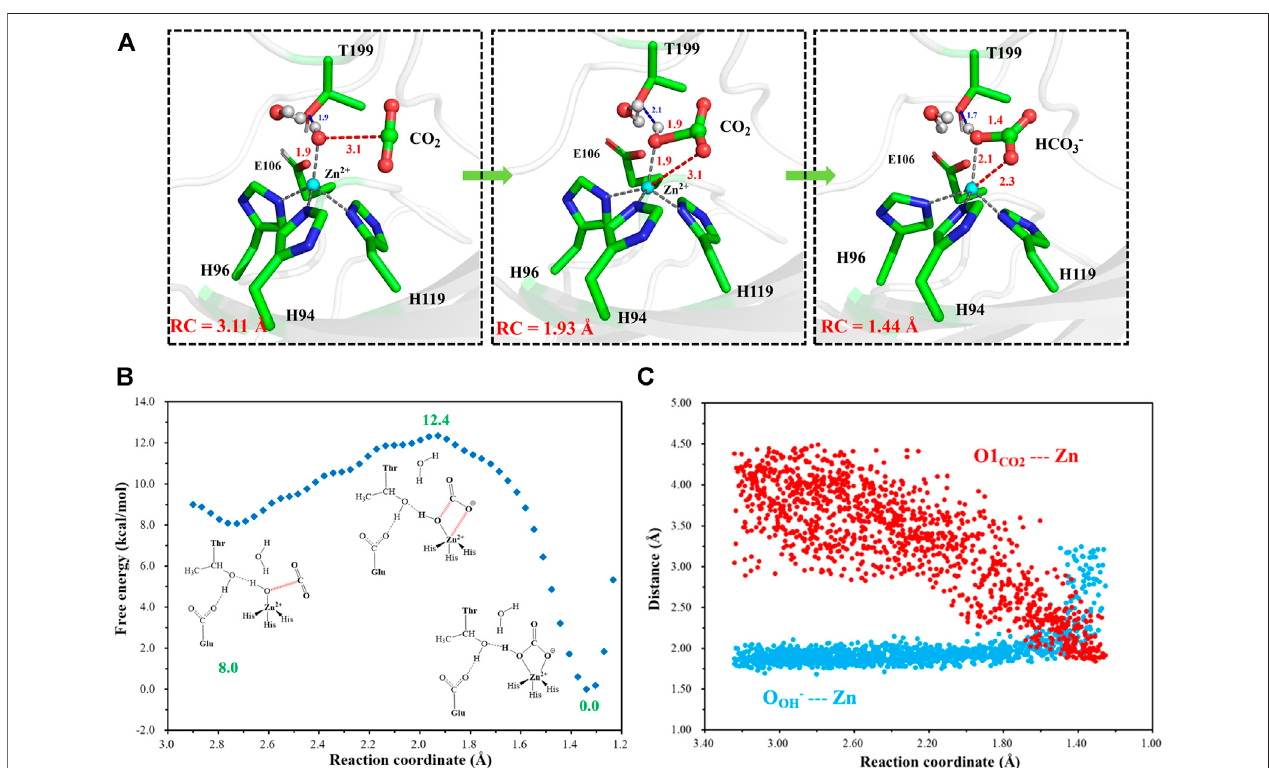
FIGURE 10 | (A) Selected representative structures of the active site in the enzymatic hydration of CO 2 . The distance between OH − @O and CO 2 @C is de fi ned as RC4. (B) Thepredictedfreeenergypro fi